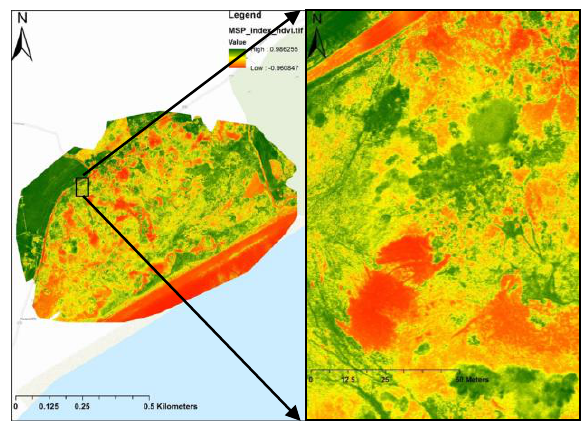
Figure 7. NDVI index map and the details in the selected